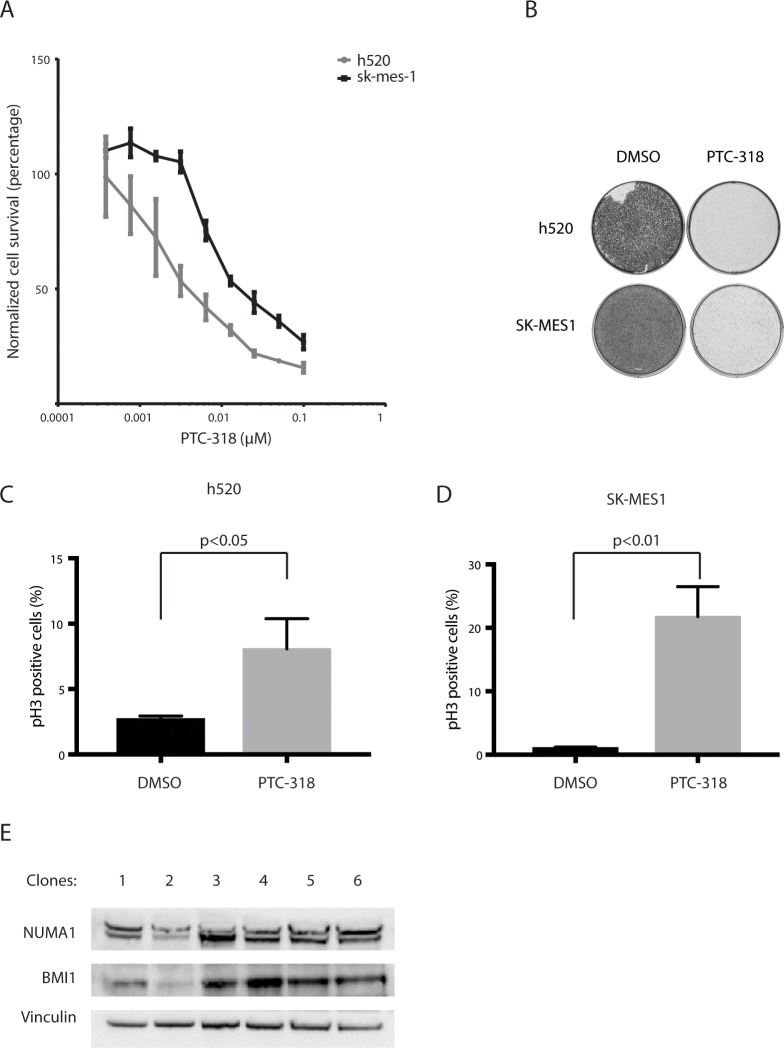
Non-small cell lung cancer cell lines are sensitive to BMI1 inhibition.(A) IC50 measurements of NSCLC cell lines h520, SK-MES-1, and SWI-1573. The x-axis shows the PTC-318 concentration in μM and the y-axis the percentage of surviving cells relative to non-treated control counterparts. (B) Colony formation of h520 and SK-MES-1 cells treated with either 0.1% DMSO or 40 nM (h520) or 80 nM (SK-MES-1) of PTC-318. (C) Percentages of h520 phospho-histone H3 populations after treatment with either 0.1% DMSO or 40 nM PTC-318 determined by flow cytometry quantification. (D) Percentages of h520 phospho-histone H3 populations after treatment with either 0.1% DMSO or 80 nM PTC-318 determined by flow cytometry quantification. Error bars represent SD (n = 3). A two-tailed Student’s t-test was performed for statistical testing. (E) Protein expression of NUMA1 and BMI1 in NUMA1-WT clones of an h520 population transfected with Cas9 targeting BMI1, single-cell sorted, and expanded.